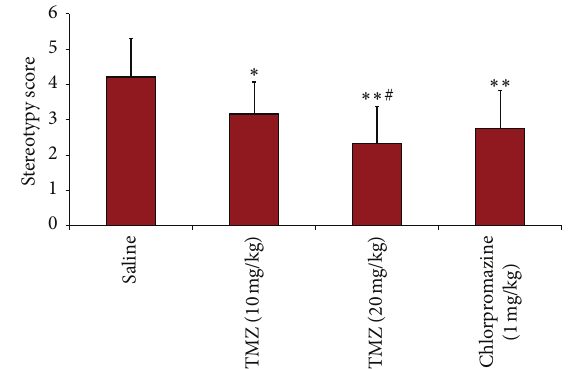
Figure 2: Apomorphine-induced stereotypy scores. Data are ex- pressed as mean ± SEM. Statistical analysis was performed by one- way analysis of variance (ANOVA) and Bonferroni’s post hoc test. ∗ different from saline, 𝑃 = 0.004 , ∗∗ different from saline, 𝑃 = 0.000 , # different from TMZ (10mg/kg), 𝑃 = 0.033